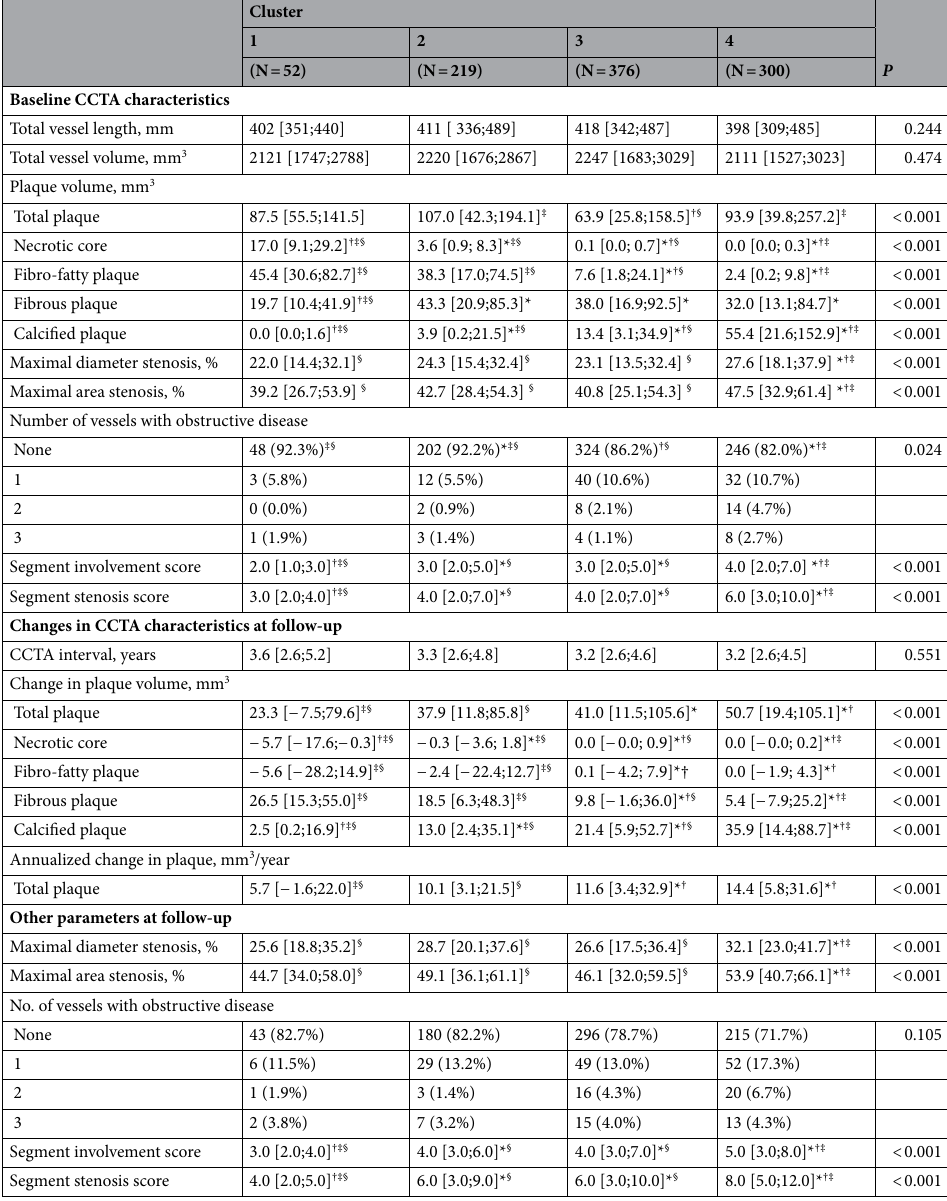
marked as * (vs. Cluster 1), † (vs. Cluster 2), ‡ (vs. Cluster 3), and § (vs. Cluster 4). CCTA = coronary computed tomographic